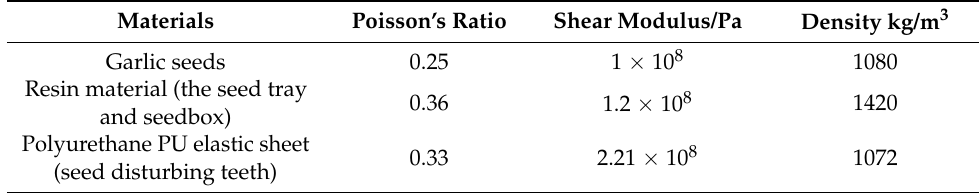
Table 2. Material parameters.